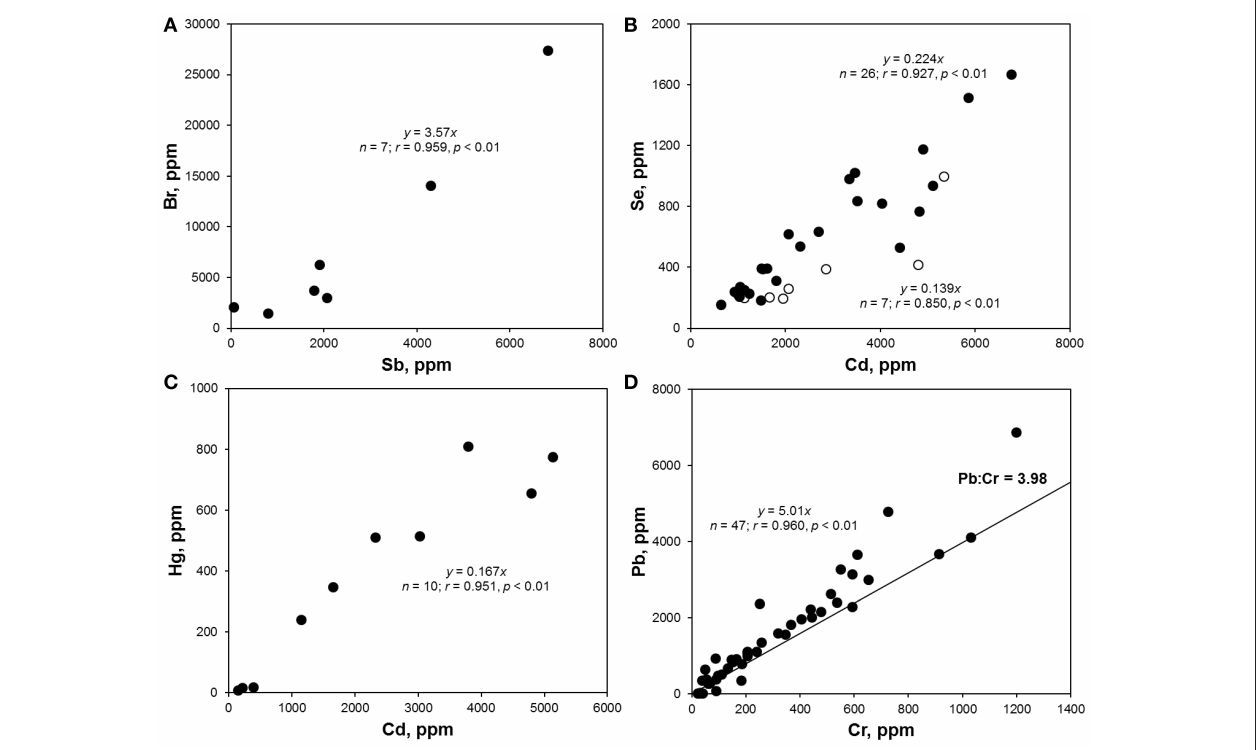
FIGURE 3 | (A) Br vs. Sb concentrations in samples where Br > 1,000 ppm; (B) Se vs. Cd concentrations in red (•) and orange ( ◦ ) plastics; (C) Hg vs. Cd concentrations in Hg-positive samples; (D) Pb vs. Cr concentrations in non-PVC-based samples that were not colored green; the line corresponds to the mass ratio of Pb to Cr in pure lead chromate. Note that parameters defining the best fit regression lines are annotated on each